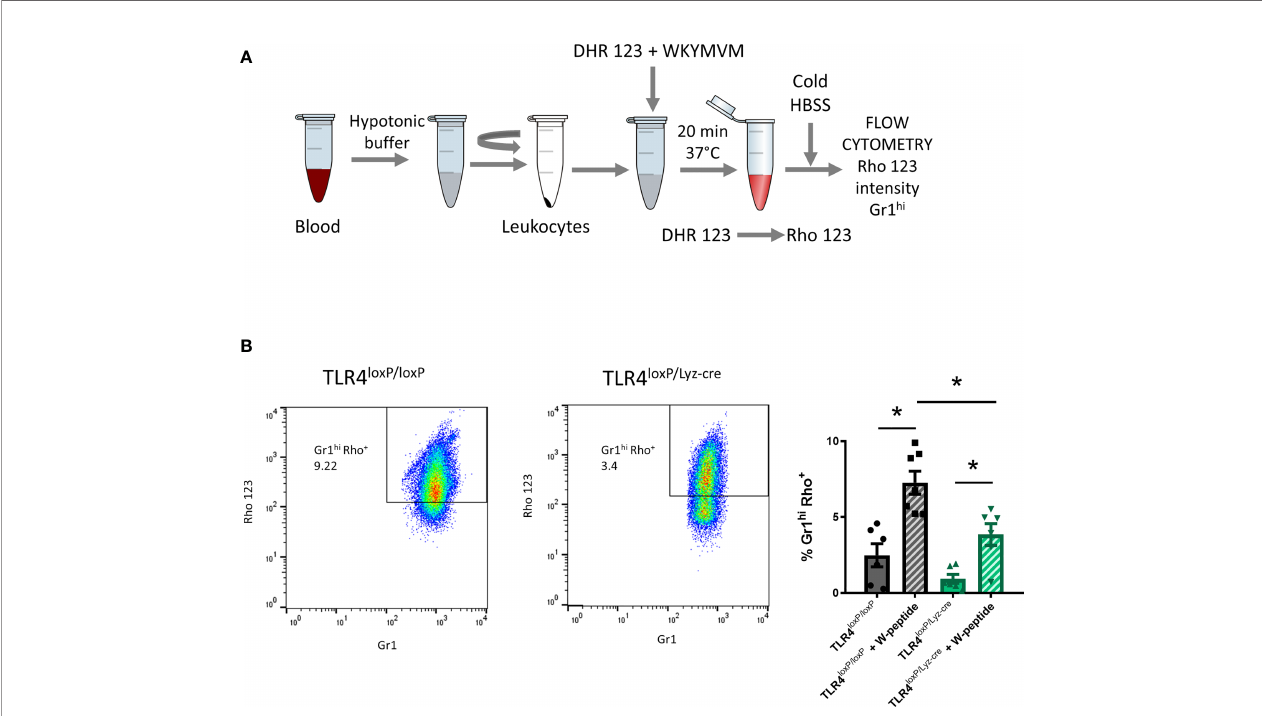
FIGURE 5 | Reactive oxygen species production. (A) Experimental design: blood was collected, RBC lysed, WBC resuspended and DHR123 and W-peptide (if necessary) were added. Samples were incubated for 20 min at 37°C. After incubation time, cold HBSS was added to stop the reaction. Cells were stained for Gr1 marker and washed. Samples were analyzed with the fl ow cytometer. (B) Flow cytometry analysis of the percentage of neutrophils producing ROS (% Gr1 hi Rho + cells) of viable cells with and without W-peptide activation (*P < 0.05, n=4-6). Data are mean ±